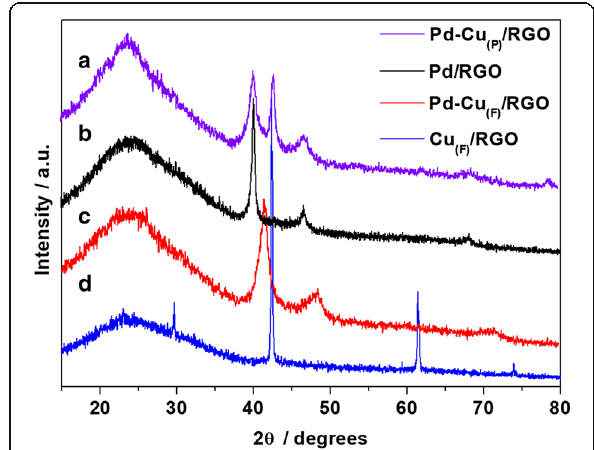
Fig. 3 XRD patterns of the Pd-Cu (P) /RGO (curve a), Pd/RGO (curve b), Pd-Cu (F) /RGO (curve c), and Cu (F) /RGO (curve d)